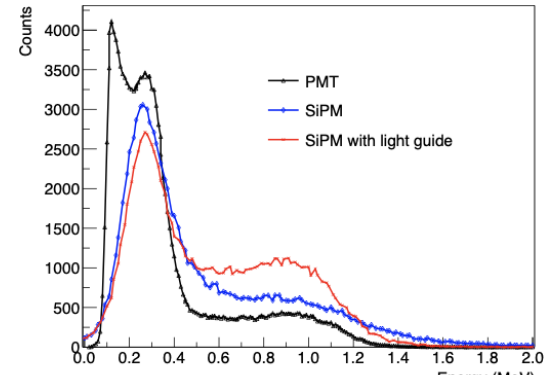
Fig. 10. 22 Na energy spectra corresponding to the 2” right cylinder of EJ-299 coupled to the PMT (H1949-51)and to the NUV-SiPM with and without light